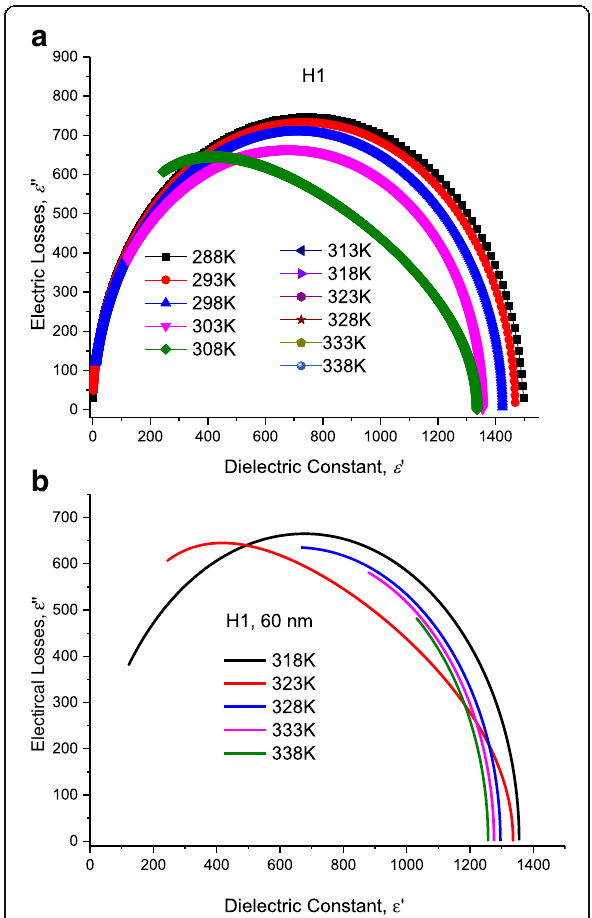
Fig. 23 Cole-Cole graph: dependence of electric losses as a function of dielectric constant for the charges at the interface between electrode and DNA (H1) at different temperatures. One notices that presence of nearly complete semicircle